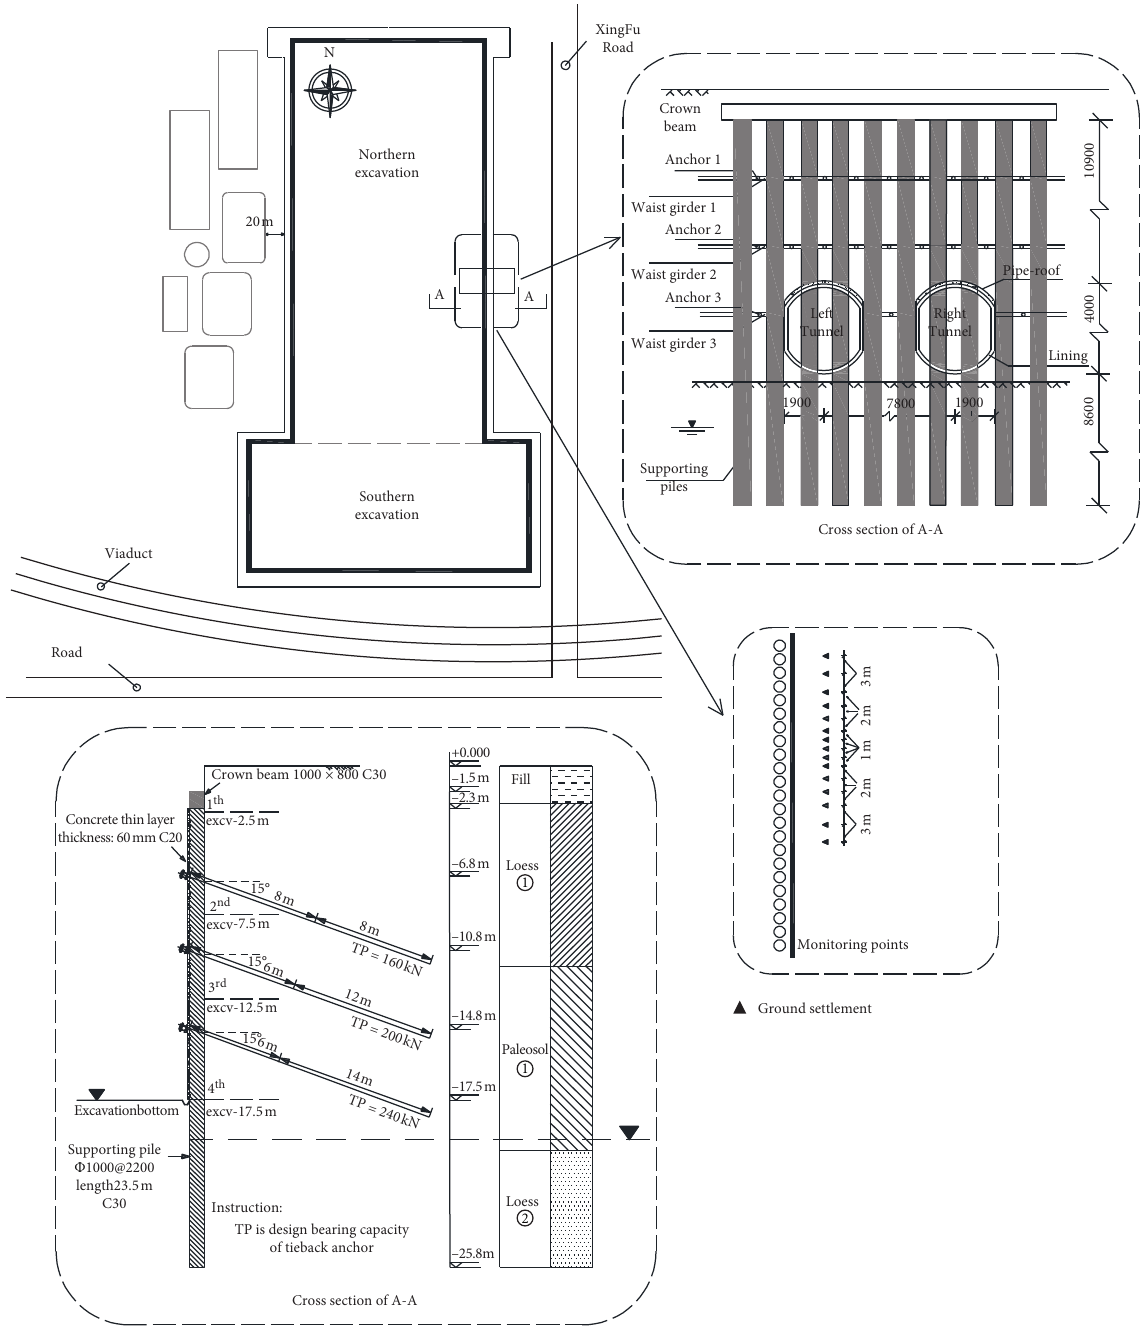
Figure 1: Soil profiles and supporting systems. Note: Φ � pile diameter and @ � pile center-to-center